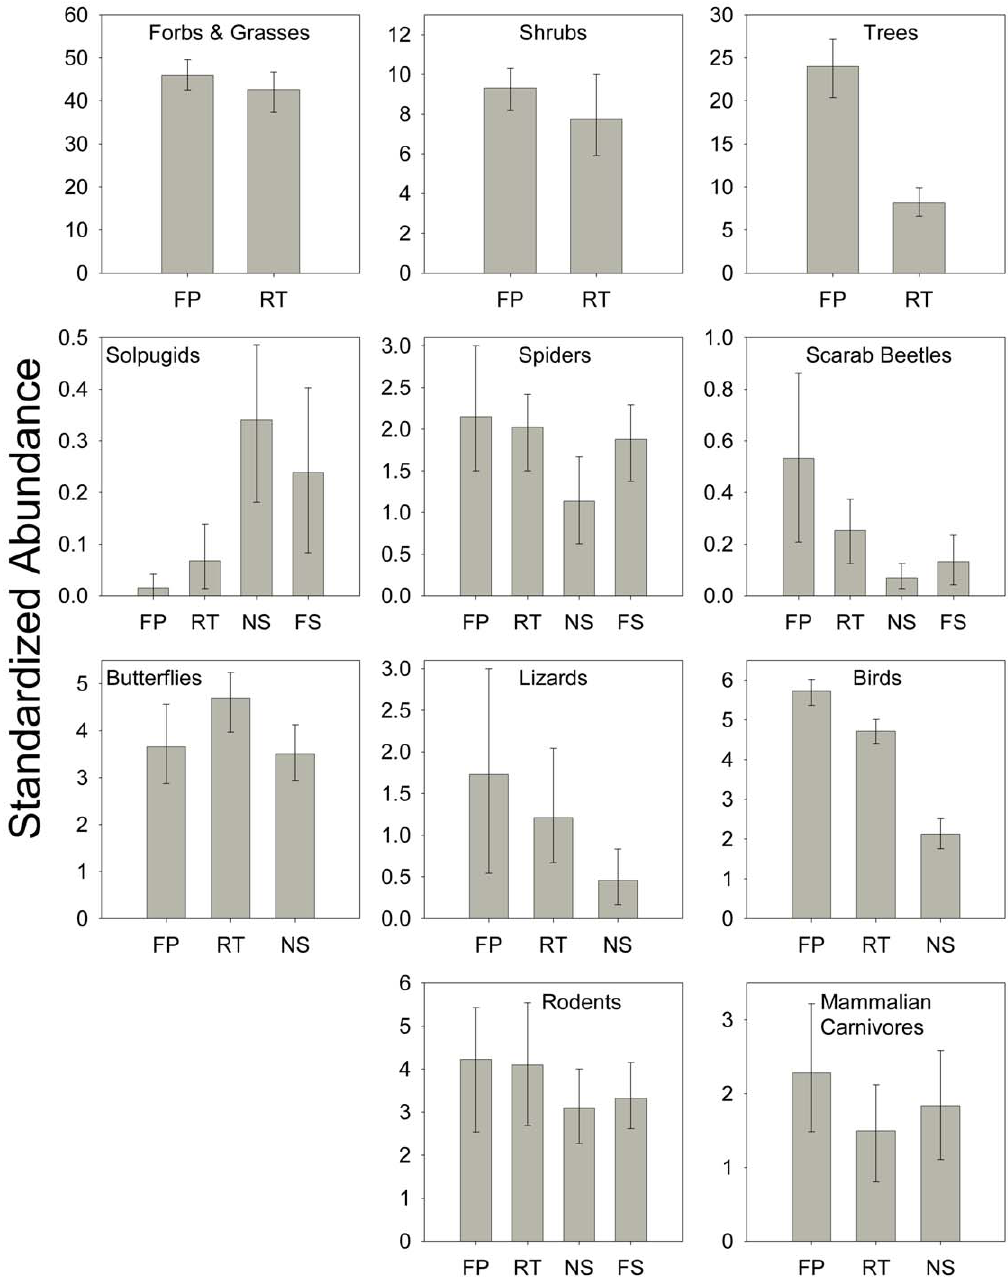
Figure 4. Abundance by habitat type for each taxonomic group. Bootstrapped abundance estimates ( 6 95% confidence intervals) in four different habitat types for the eleven taxa sampled along the upper San Pedro River (abbreviations as in Table